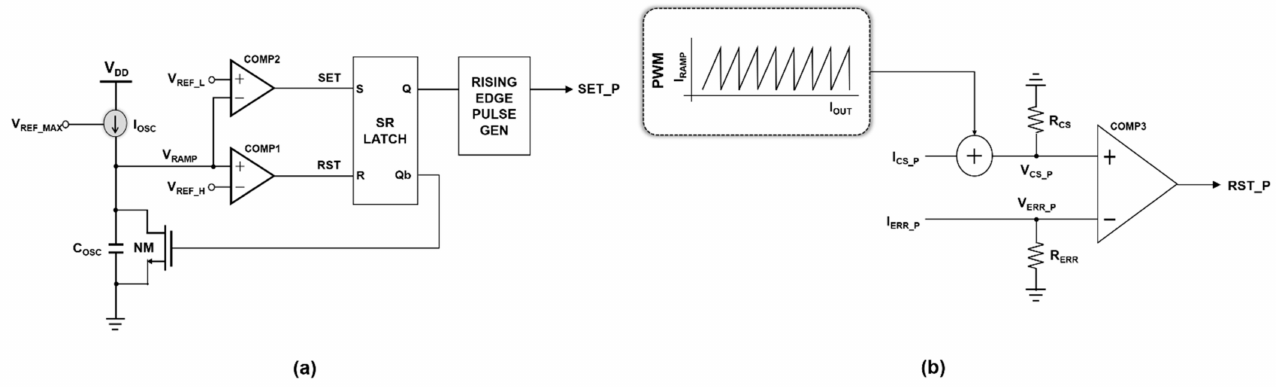
Figure 4. PWM controller circuit PWM_CTRL of the boost converter: ( a ) SET_P generation circuit; ( b ) RST_P generation